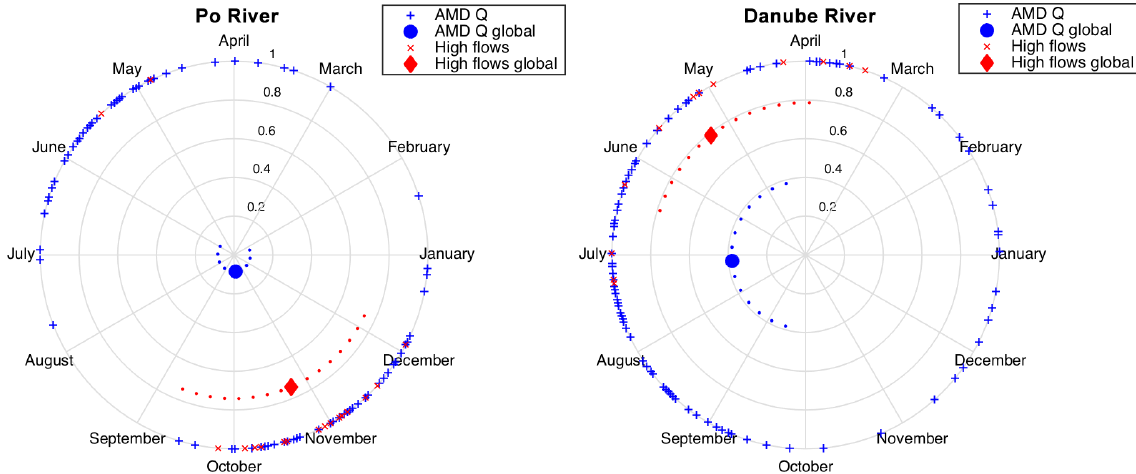
Figure 3. Seasonality space representation of the annual maximum daily flows (AMD) and high-flow events. Dots around the global value indicate the dispersion. Table 3. Pearson’s cross-correlation coefficient and its 95 % confidence interval between both, NQ p and NQ mf , and NQ m for varying antecedent monthly flow. Flood season in the Po: October–November. Flood season in the Danube: May–July.